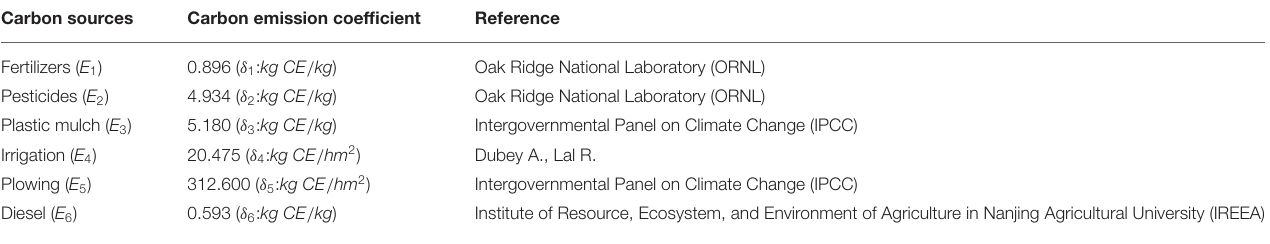
TABLE 1 | The carbon emission coefficient of major crop farming sources.